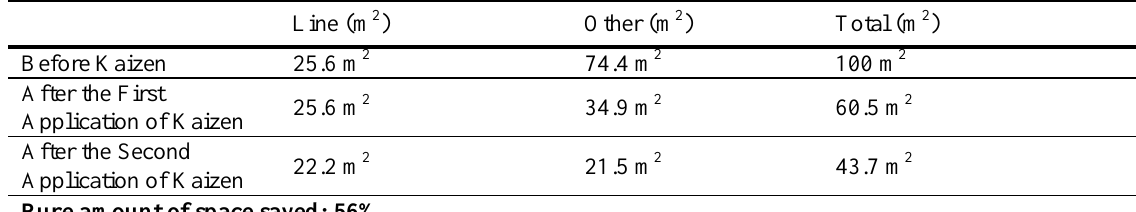
Table 3. The Pure Usage in the Line for Water